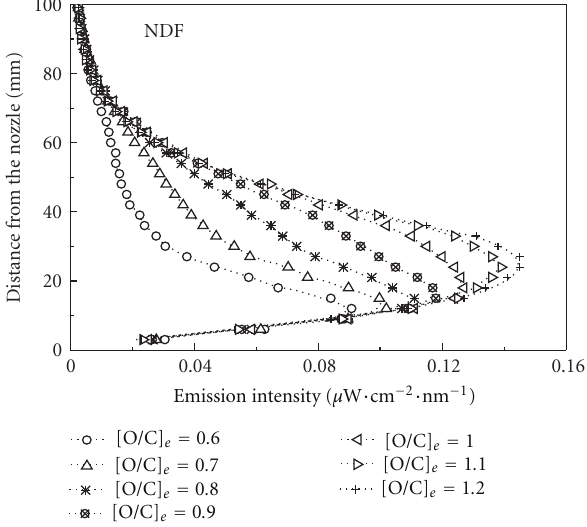
F 7: e change of OH [ ] 𝑒𝑒